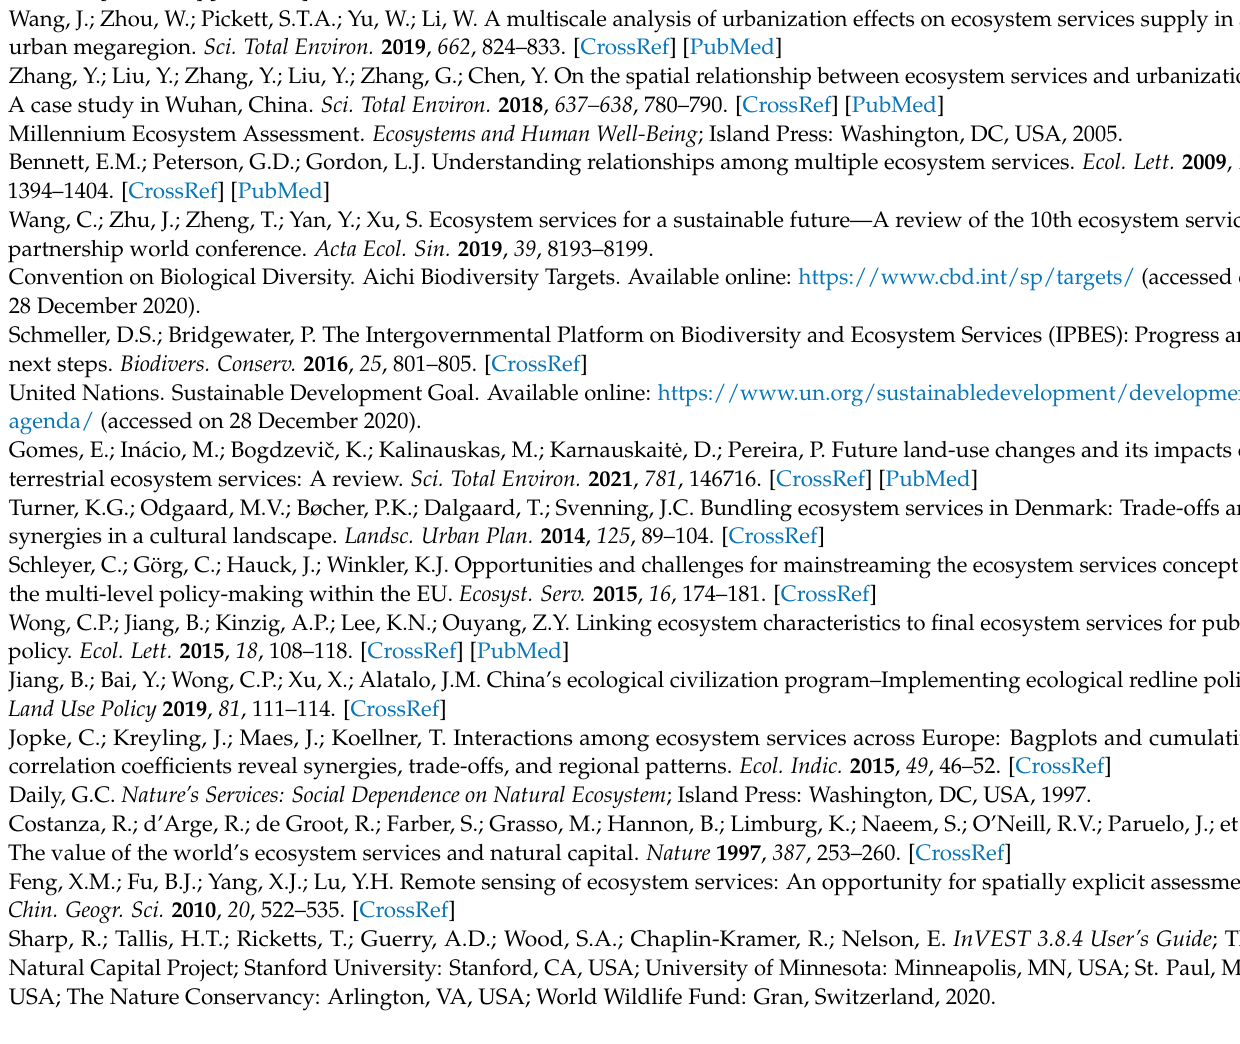
GAM showing the effect of driving factors, Figure S4: Area proportion of ecosystem services bundles (ESBs) in different ESs hotspots (a) and area proportion of multiple ES hotspots in different ESBs (b) in